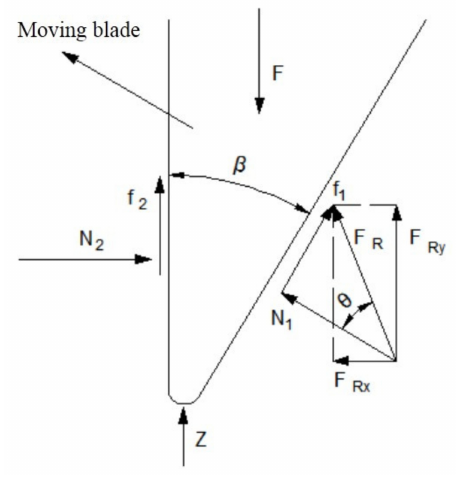
Figure 12. Force diagram of the moving knife during